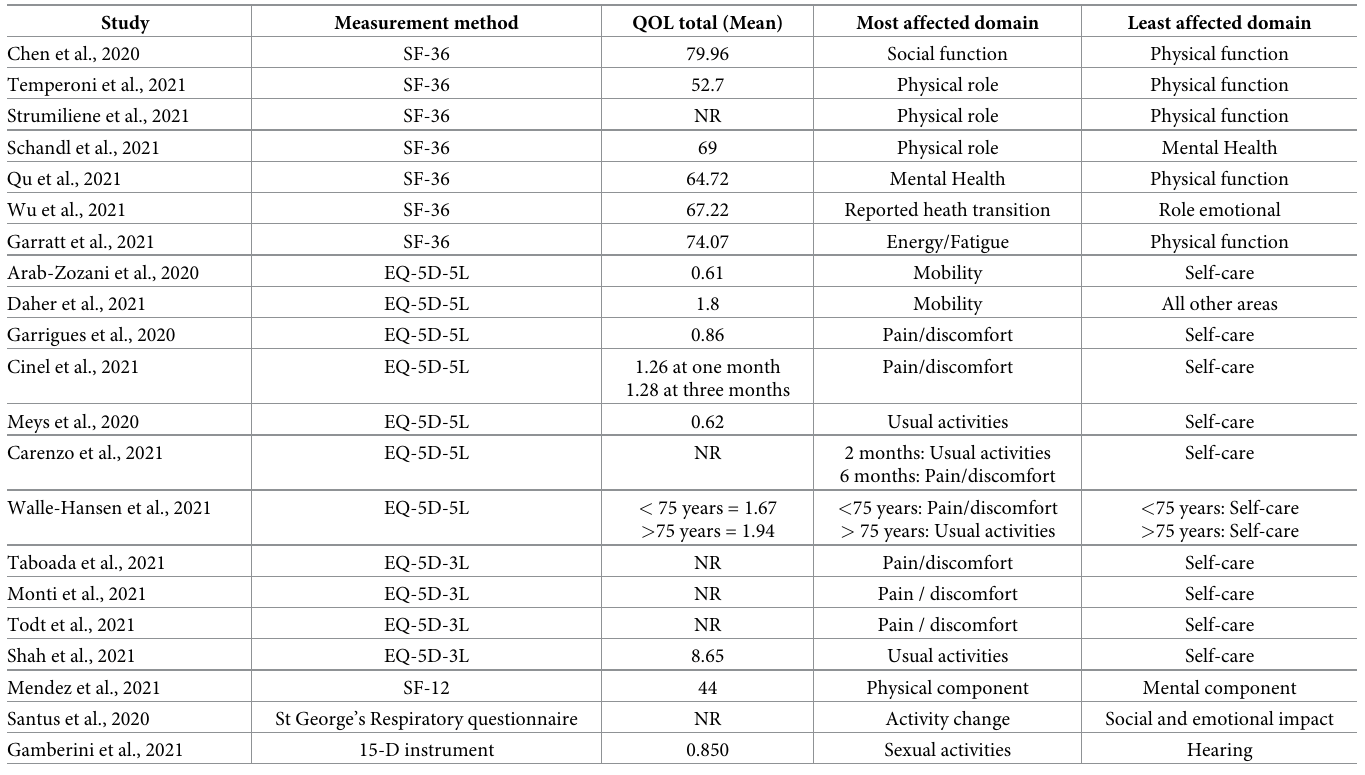
Table 2. Mean scores of QOL reported in the included